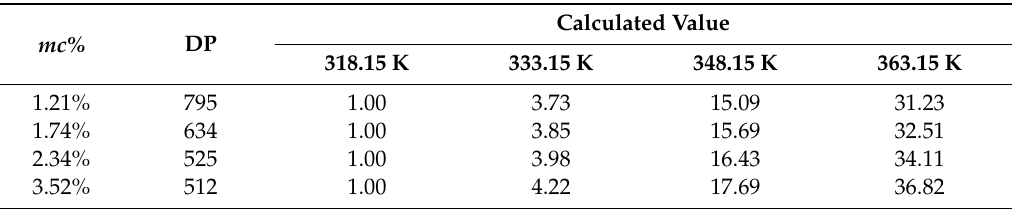
Table 5. Calculation results of the prediction time-shift factors.